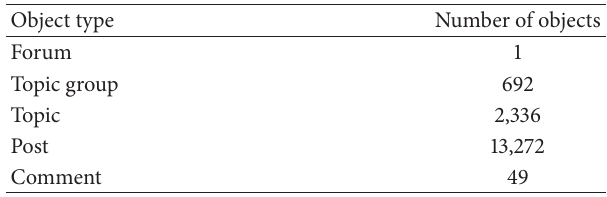
Table 1: Objects quantity in the experimental dataset.